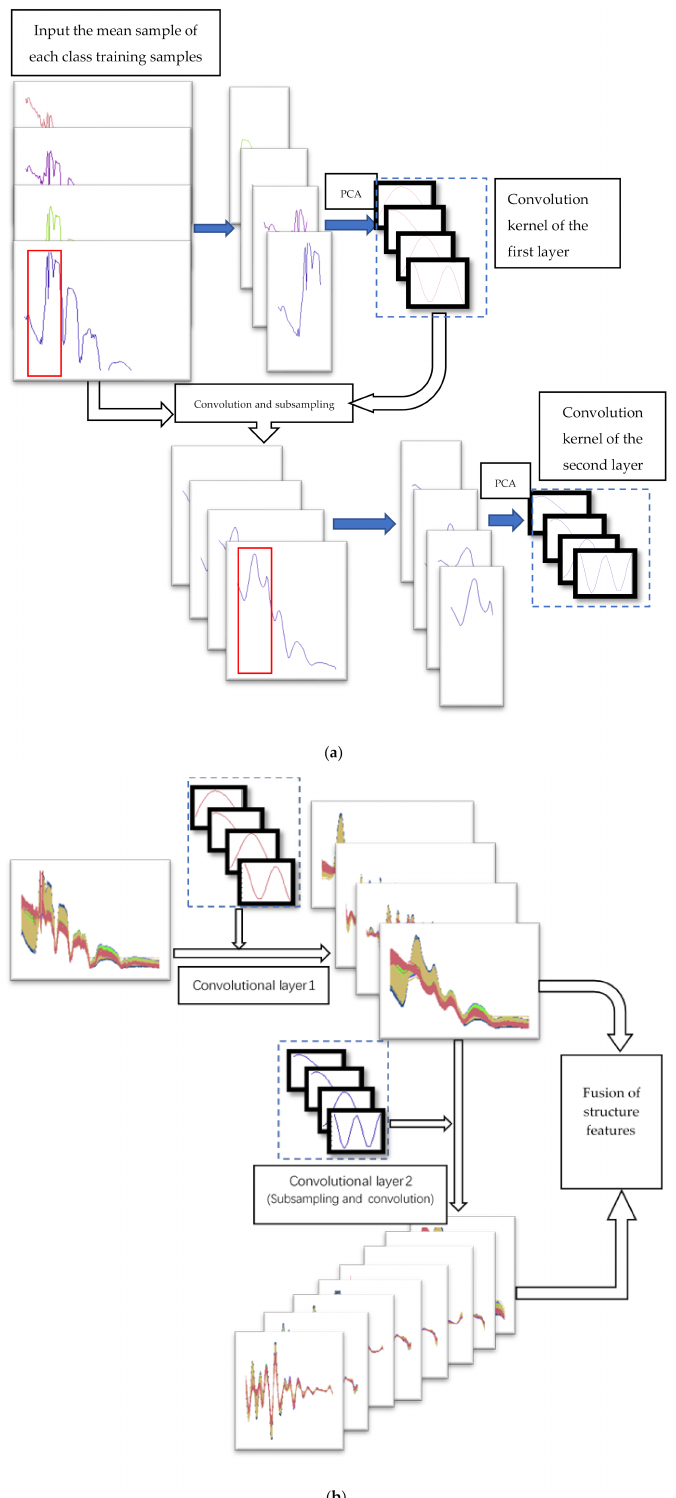
Figure 6. Flow chart of feature extraction of multi-layer structure: ( a ) the flow chart of generating the convolution kernel for structure feature extraction, and ( b ) the flow chart of structural feature extraction of hyperspectral